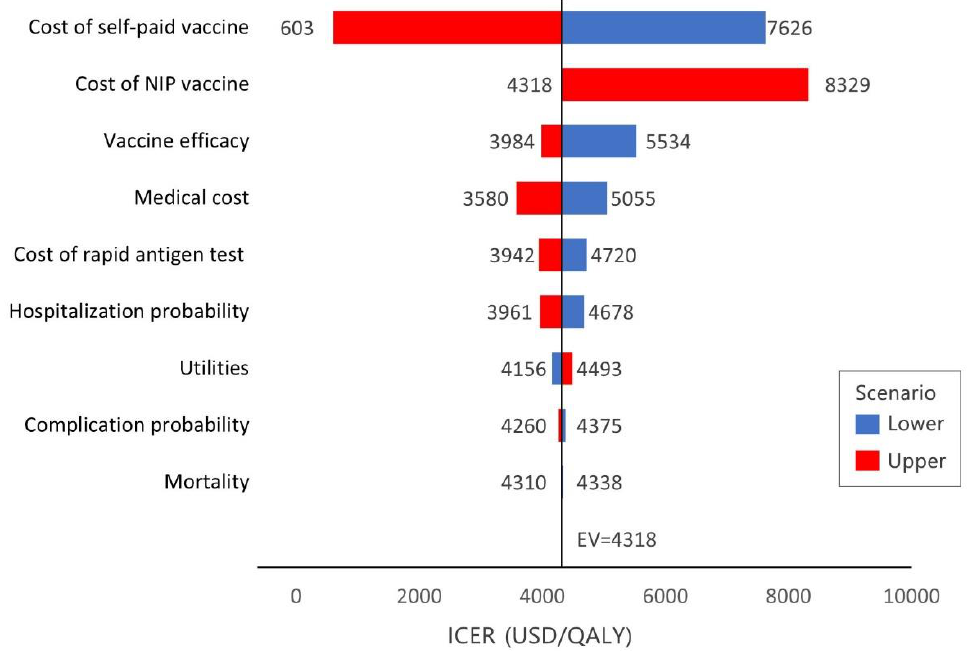
Figure 3. Cost-effectiveness acceptability curve by scenario: Scenario 1 (H) represents the base case from a healthcare sector perspective, Scenario 2 (H) represents 60% coverage for individuals aged 50 – 64 years from a healthcare sector perspective, Scenario 3 (H) includes only individuals aged 60 – 64 years in the policy from a healthcare sector perspective, Scenario 5 (H) has no indirect effects from a healthcare sector perspective, Scenario 1 (S) represents the base case from a societal perspec- tive, Scenario 2 (S) represents 60% coverage for individuals aged 50 – 64 years from a societal per- spective, Scenario 3 (S) includes only individuals aged 60 – 64 years in the policy from a societal per- spective, Scenario 5 (S) has no indirect effects from a societal perspective. The threshold of willing- ness-to-pay is USD 30,681 per quality-adjusted life years.